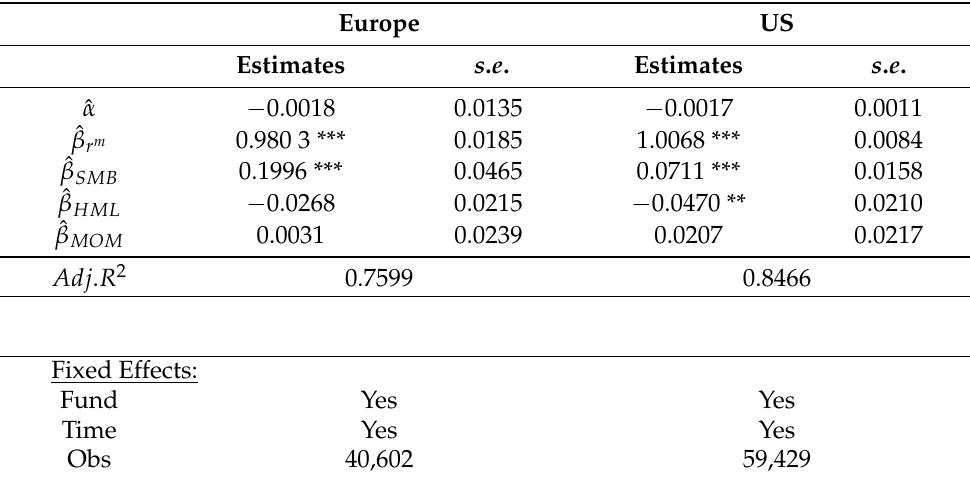
Table 5. Estimation of the panel version of Carhart’s model (2013–2018).